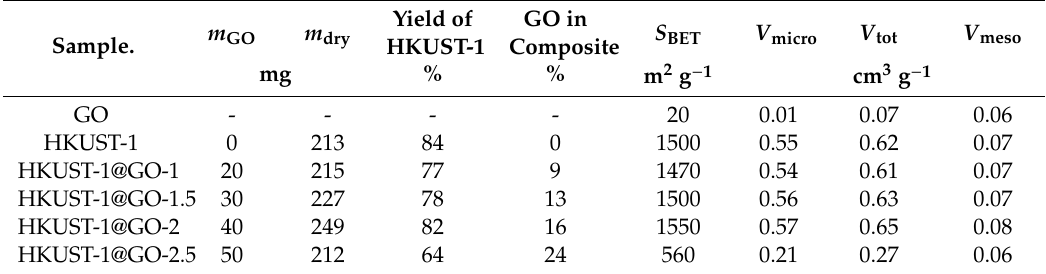
Table 1. Composition of HKUST-1@GO samples and their characteristic data from low temperature nitrogen adsorption–desorption isotherms *.